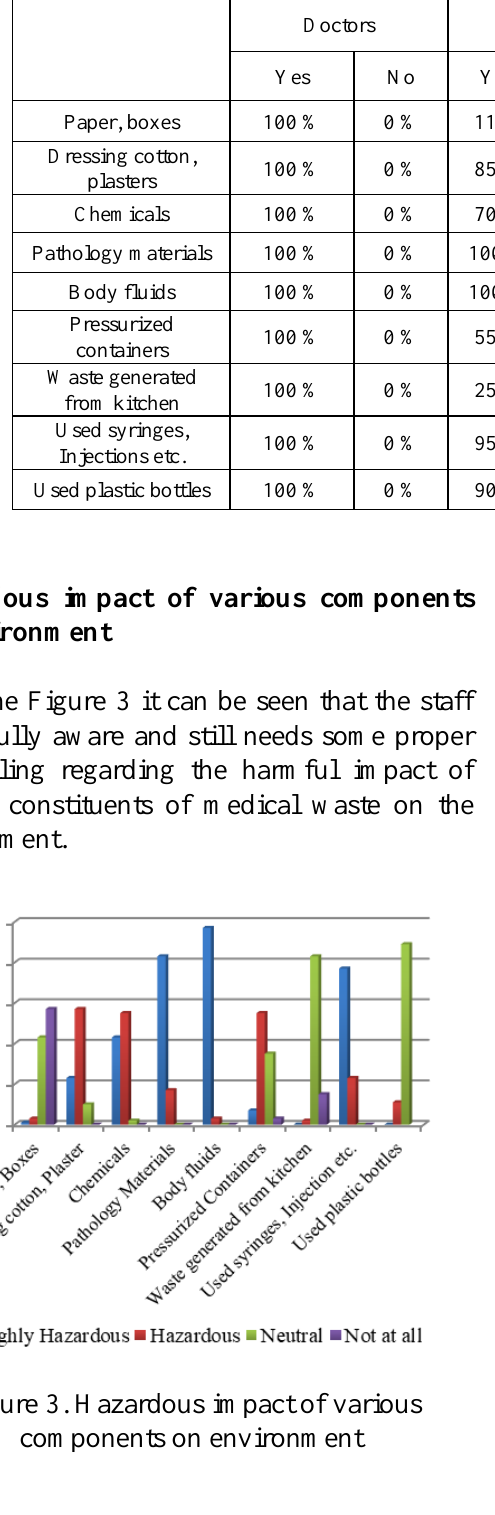
Table 4. Components of medical waste